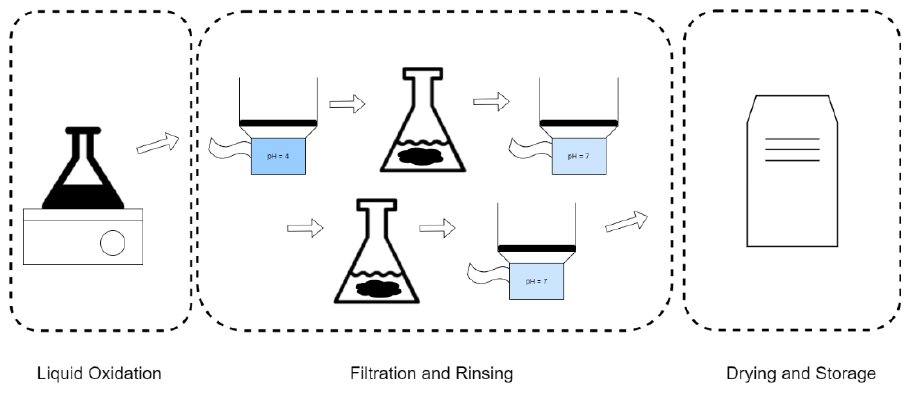
Figure 2. Diagram of liquid oxidation treatment process.